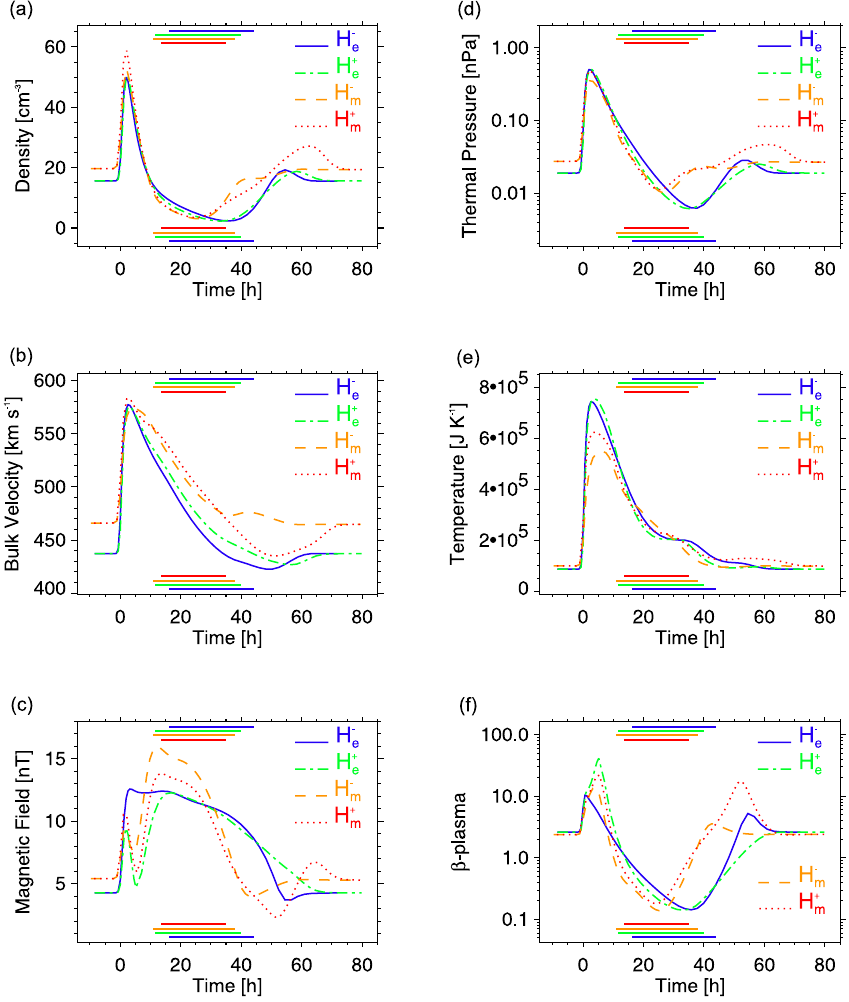
Fig. 18. Number density (a) , bulk velocity (b) , magnetic field strength (c) , thermal pressure (d) , temperature (e) , and plasma- β (f) measured by a virtual spacecraft at 1AU near the equatorial plane. Profiles of the equatorial propagation scenarios ( H − e , H + e ) and of the meridional propagation scenarios ( H − m , H + m ) are all superposed. Shock times are synchronized to 0 . 0 h. Horizontal bars indicate the MC’s interior which is, by definition, bounded by the outermost closed magnetic field line encircling the